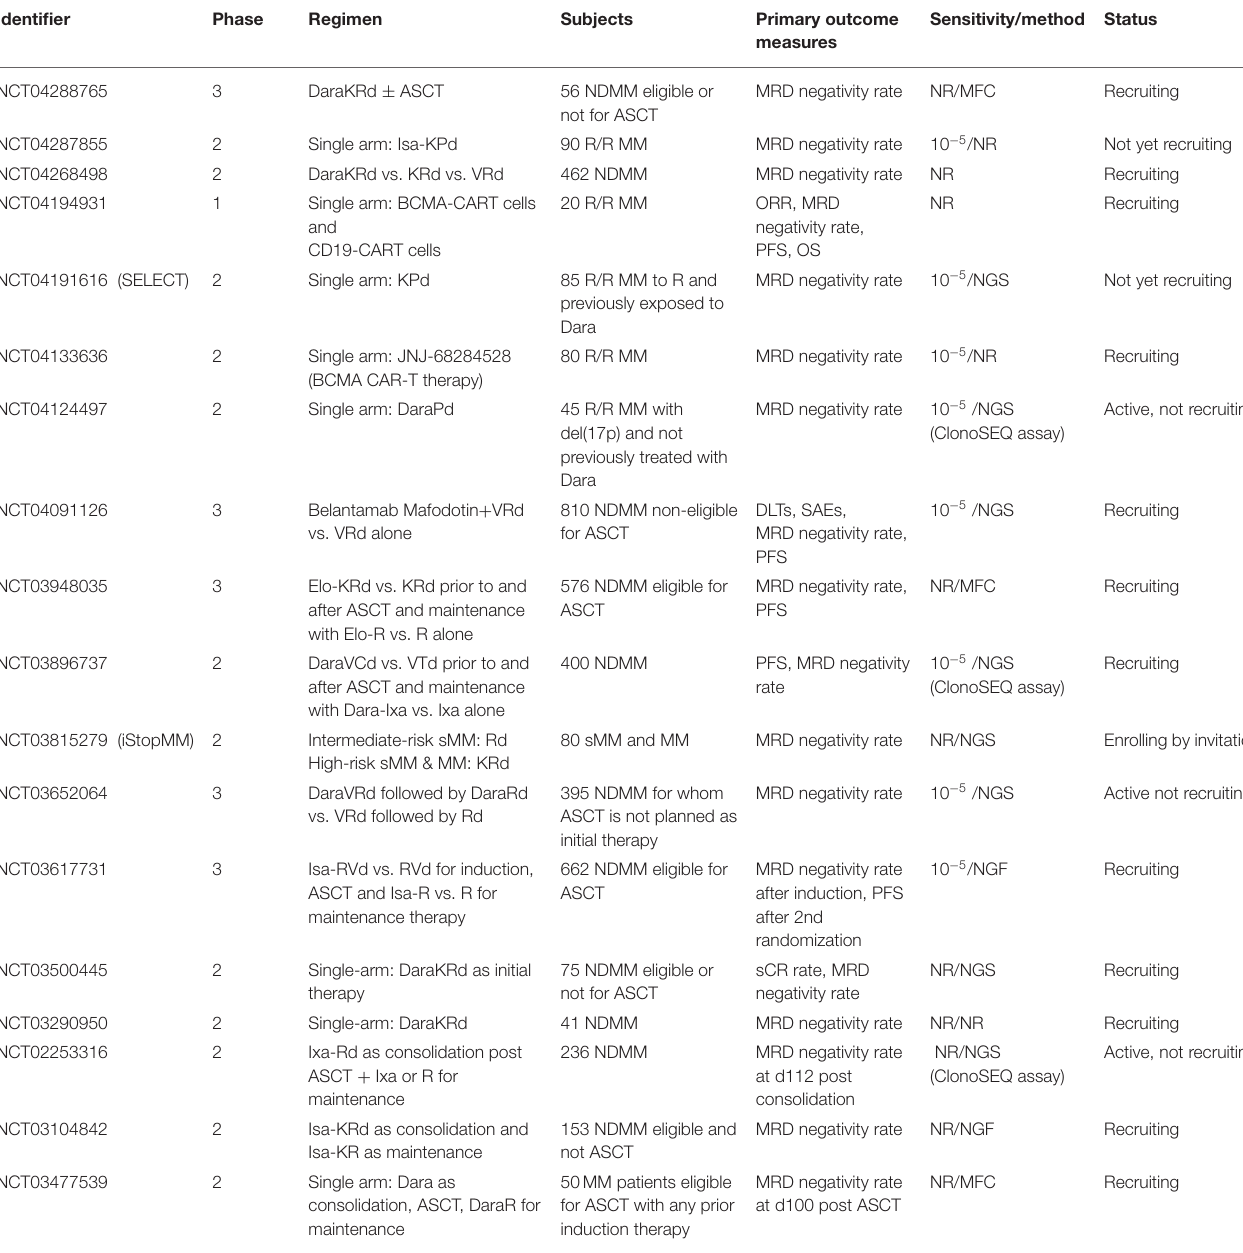
TABLE 2 | Ongoing clinical trials including MRD as a primary clinical endpoint.